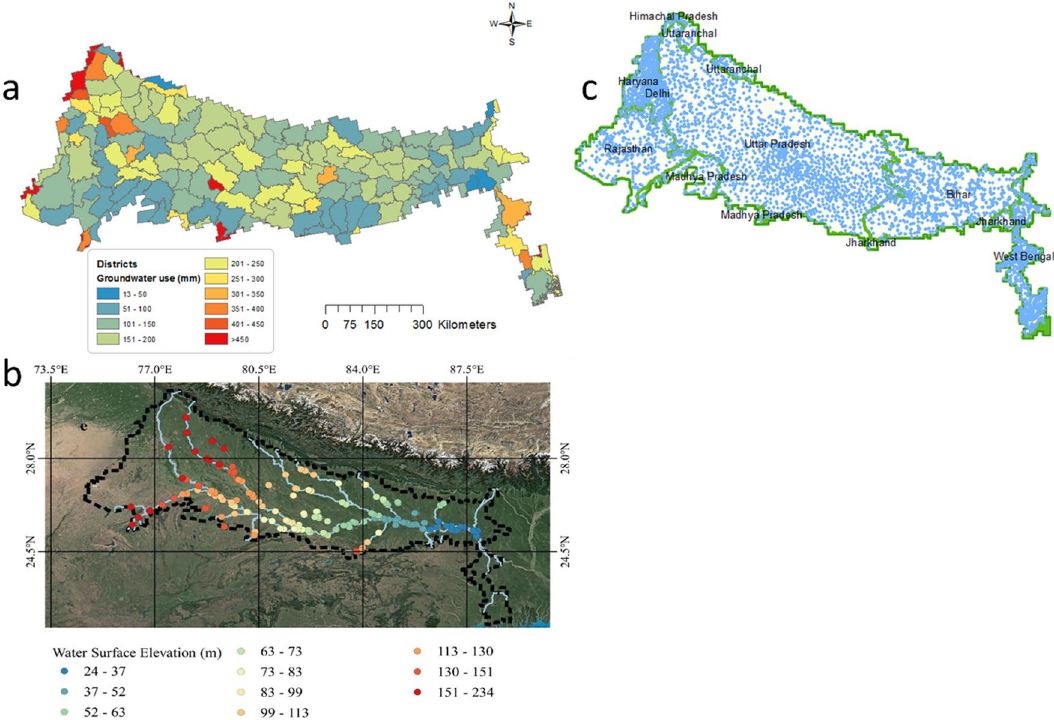
Figure 2. ( a ) Estimated annual groundwater abstraction at the district scale. ( b ) Mean water surface elevation during a period of 14 years from 2003 to 2016. ( c ) Location of monitoring bores and state boundaries within the model